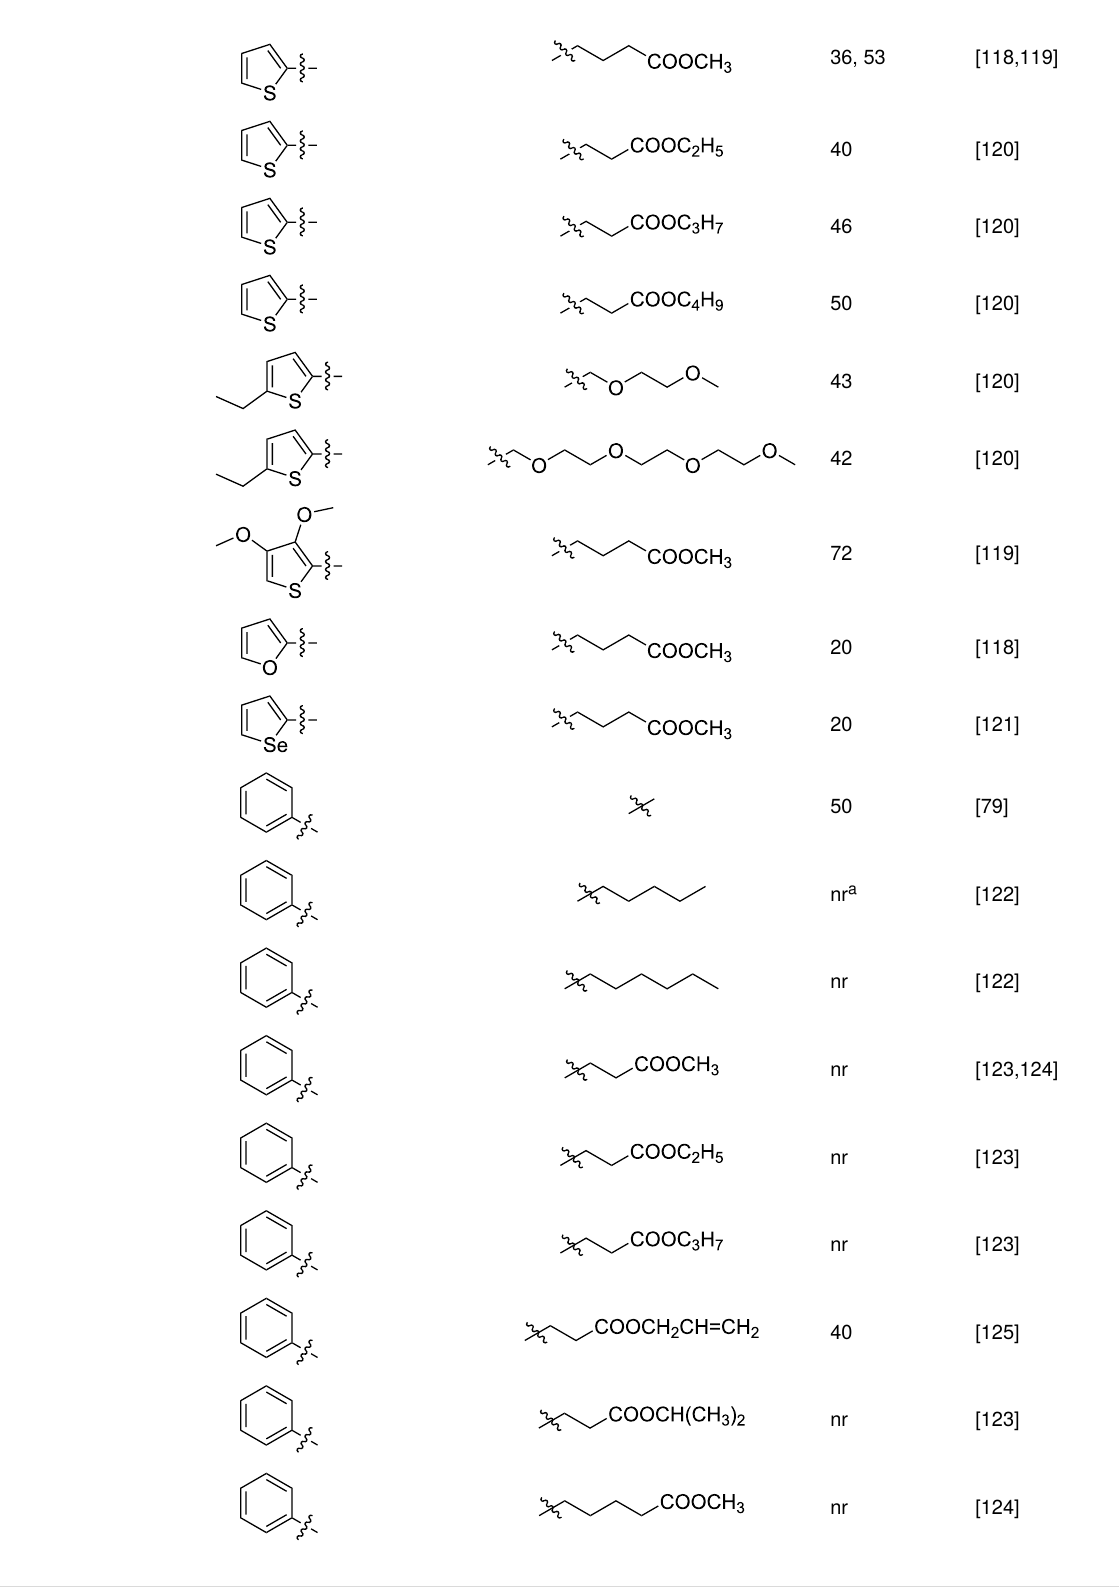
Table 1: [60]PCBM derivatives containing various aromatic and alkyl groups bound to the C 60 core.